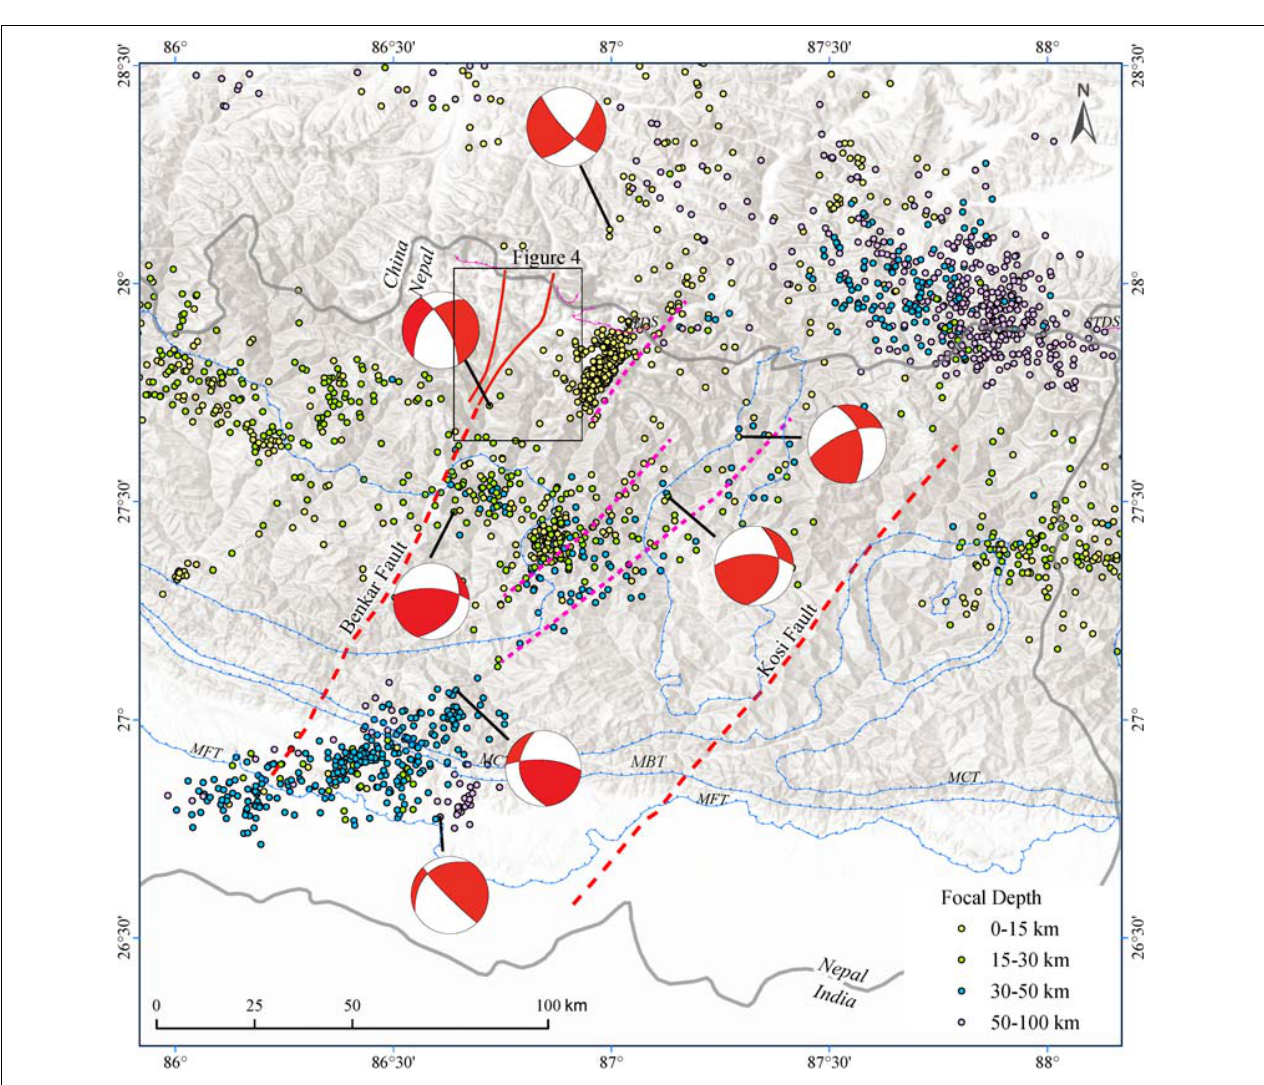
FIGURE 6 | Map of seismic events (magnitude > 1) in eastern Nepal during the time interval 1995–2003. Clusters of microseismicity align with the previously identified Benkar and Kosi Fault zones (red dashed lines), but there are other areas where the seismicity aligns along NE-oriented trends (pink dashed lines). Seismicity locations and depths from Rajaure et al. (2013) and focal mechanisms from Shanker et al. (2011). MBT: Main Boundary Thrust; MCT: Main Central Thrust; MFT: Main Frontal Thrust; STDS: South Tibetan Detachment